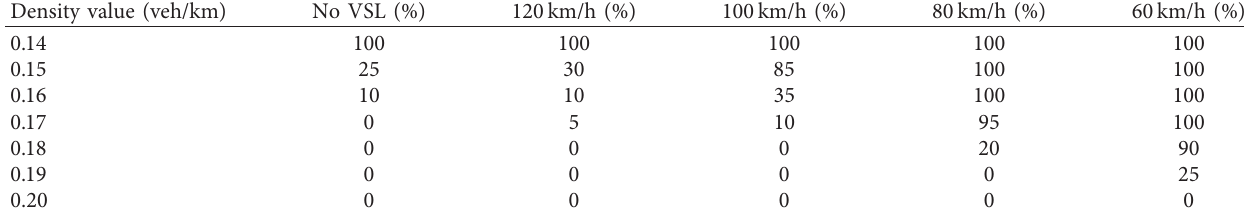
Table 5: Proportion of free-flow characteristics at different density limits in time-space diagrams.